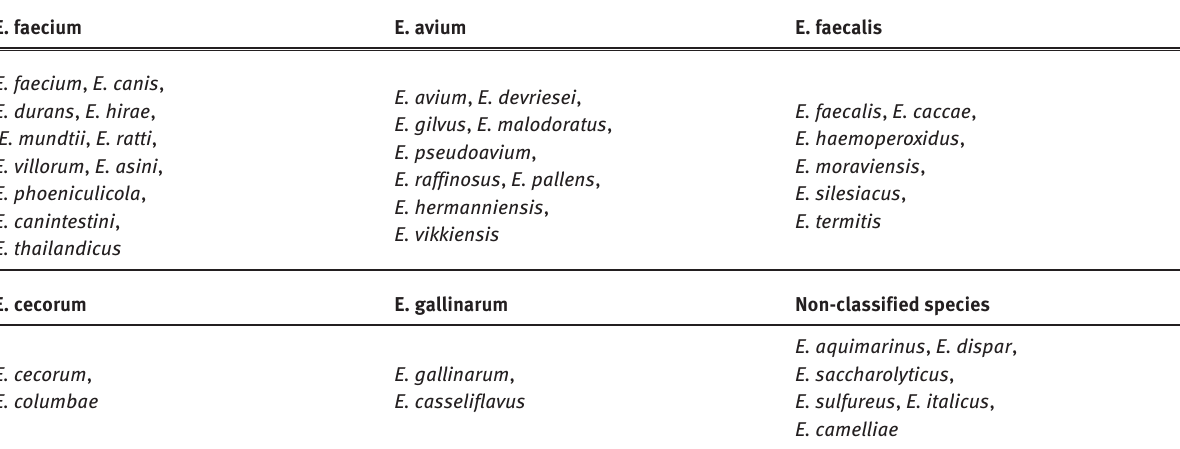
Table 1: Division of phylogenetically similar species of the Enterococcus genus [26]